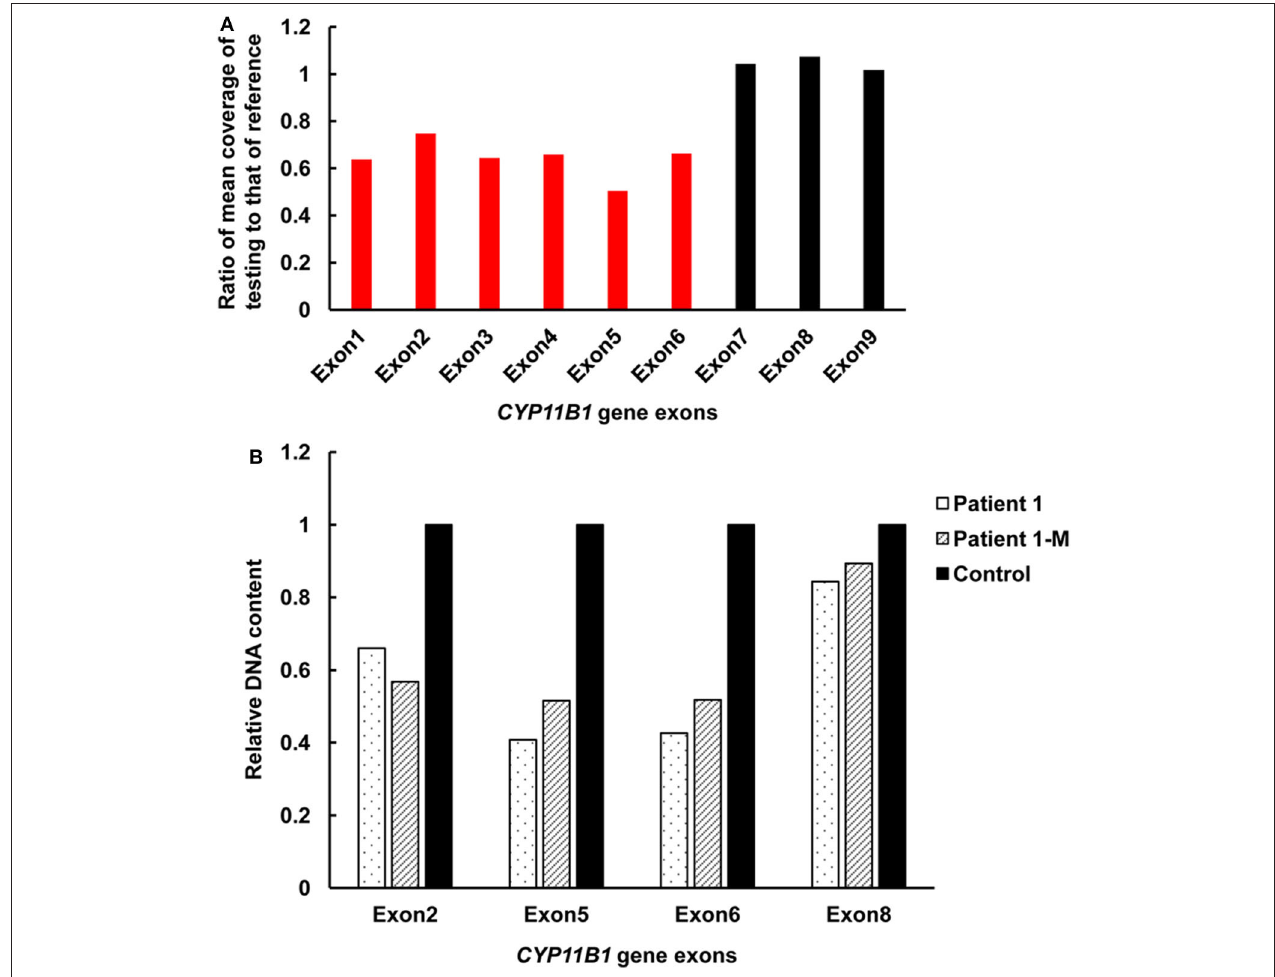
FIGURE 2 | Detection of exonic deletions of the CYP11B1 gene in patient 1 by CNV analysis using NGS coverage depth and qPCR. (A) A heterozygous deletion of exons 1–6 in the CYP11B1 gene was detected by NGS coverage depth analysis. (B) qPCR analysis of relative DNA content in whole blood from patient 1, the mother of patient 1, and the control subject. CNV, copy-number variant; NGS, next-generation sequencing; qPCR, quantitative polymerase chain